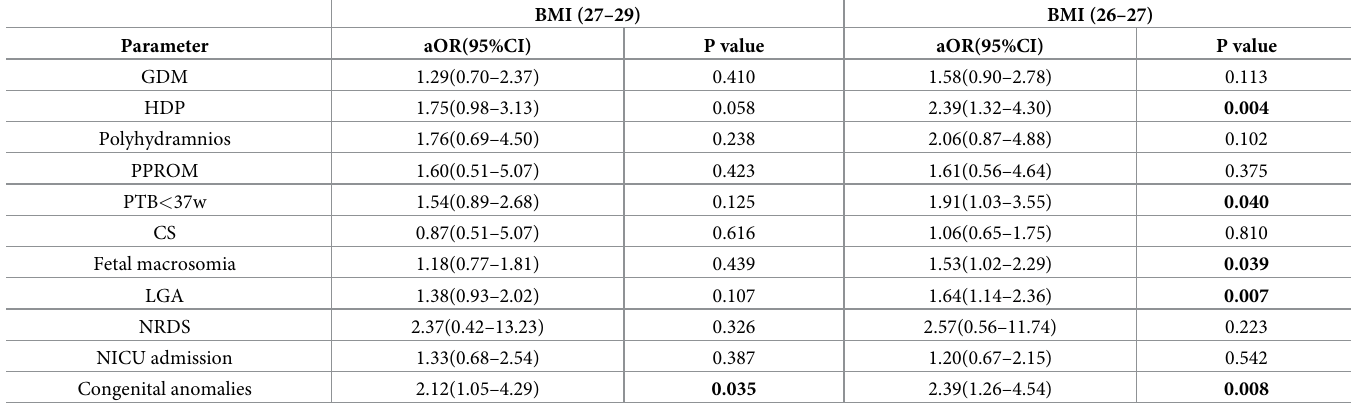
Table 7. Comparisons of adverse perinatal outcomes between target BMI group (BMI of 30–32) and BMI reduction